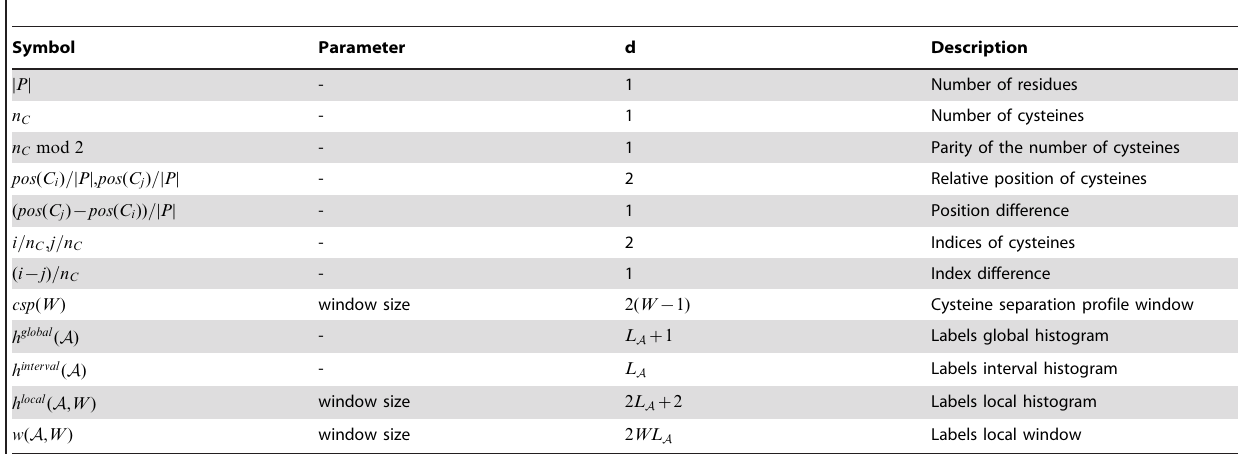
Symbols, parameters, number of features (d) and description of our candidate feature functions. Top: feature functions that are directly computed from the primary structure. Bottom: feature functions defined for every kind of annotation A [ f AA , PSSM , SS 3, SS 8, SA , DR , StAl g